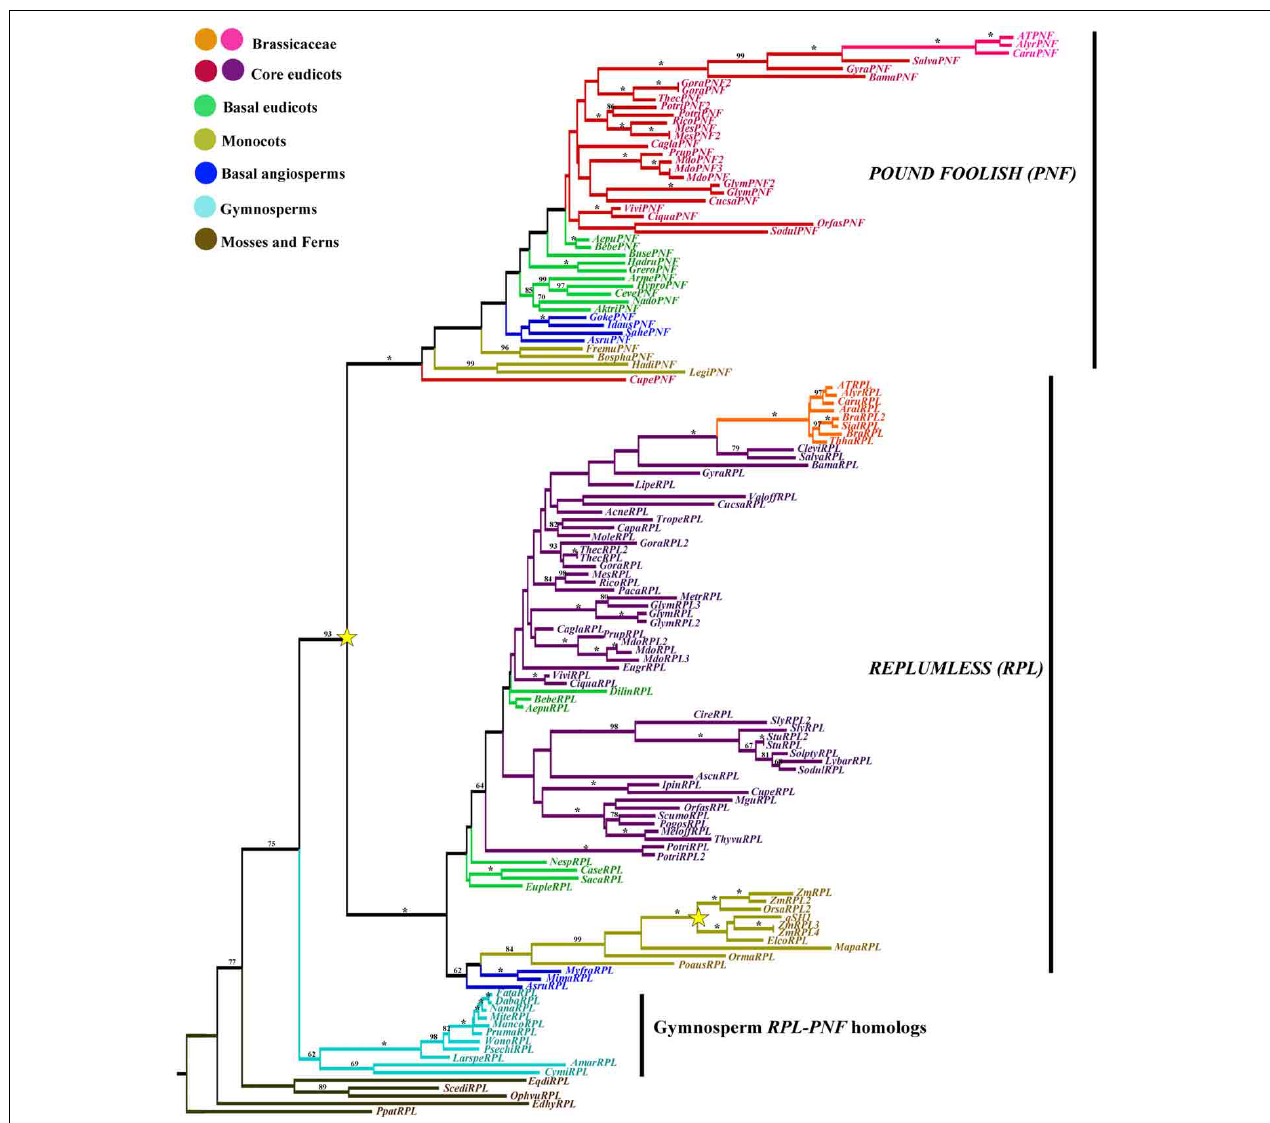
FIGURE 11 | ML tree of REPLUMLESS/POUNDFOOLISH genes in seed plants showing two duplications (star). One coinciding with the origin of the flowering plants, resulting in the RPL and the PNF clades. A second one